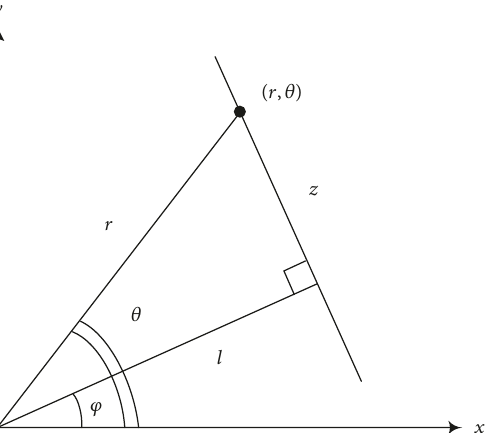
Figure 2: Reconstruction of the regional discrete diagram. This region was divided into 𝑁 equal square meshes 𝐶 𝑗 ( 𝑗 = 1,...,𝑁 ). A microwave link 𝐿 𝑖 is taken as an example, where the transmitting and receiving terminals are 𝑆 and 𝑅 ,